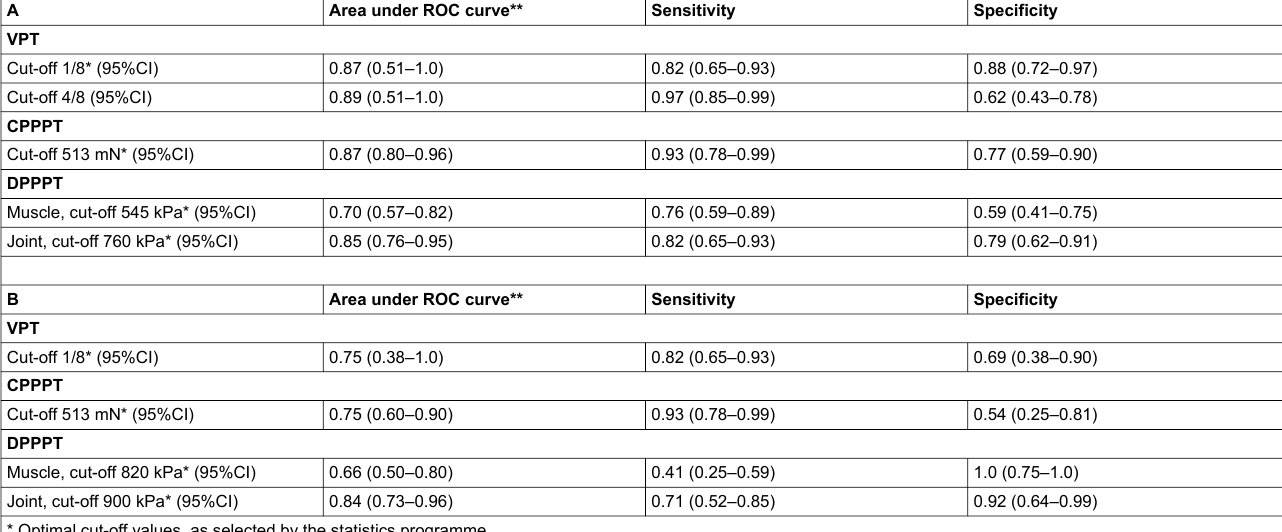
Table 4: Performance of the applied tests to identify diabetic patients with present or past plantar ulcer (n = 34) among a total of 68 diabetic patients with and without PDN (A), and among a subgroup of 47 patients with PDN